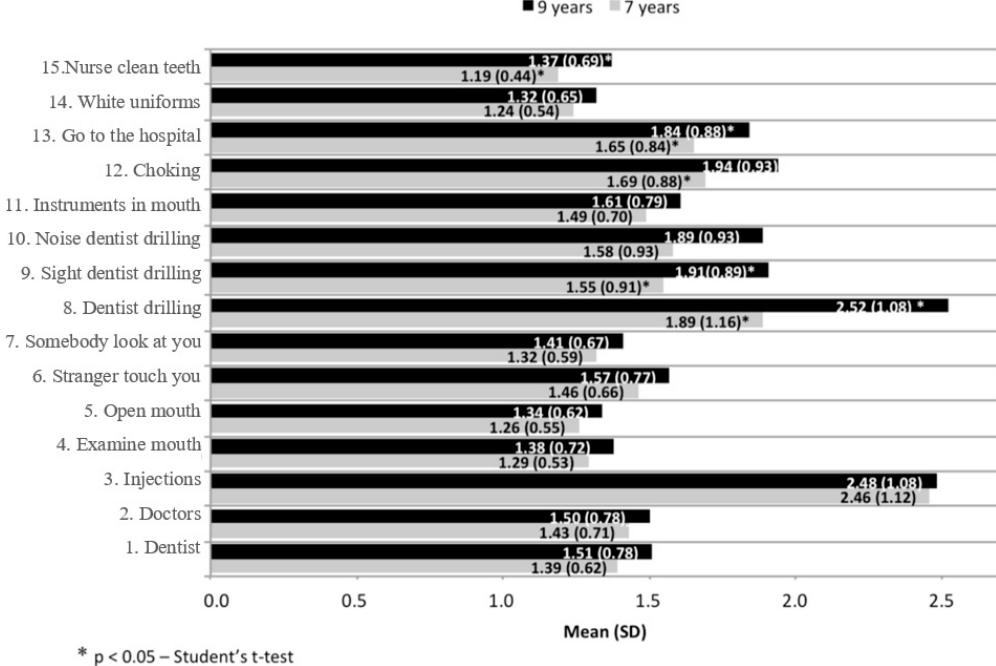
Figure 1. Mean of the responses for the items on the children’s fear survey schedule-dental subscale (CFSS-DS) at ages seven and nine years. Y-axis: Do you fear.